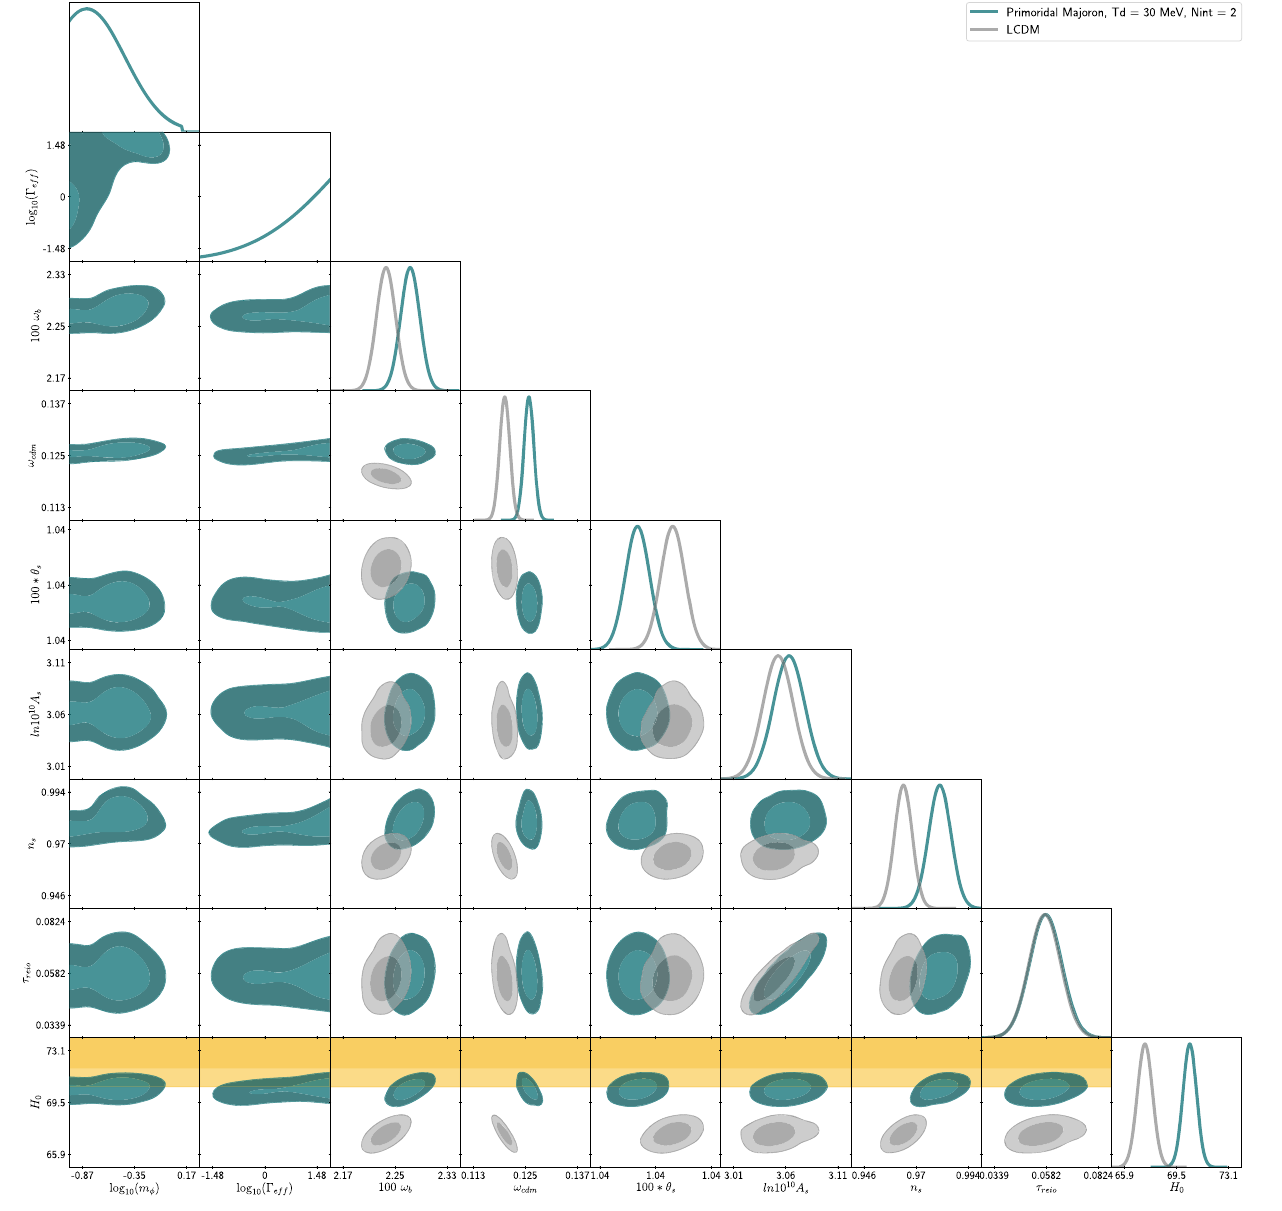
Fig. 12 Same as Fig. 11 but for the low decoupling temperature model, with T d = 30 MeV, and assuming N int =